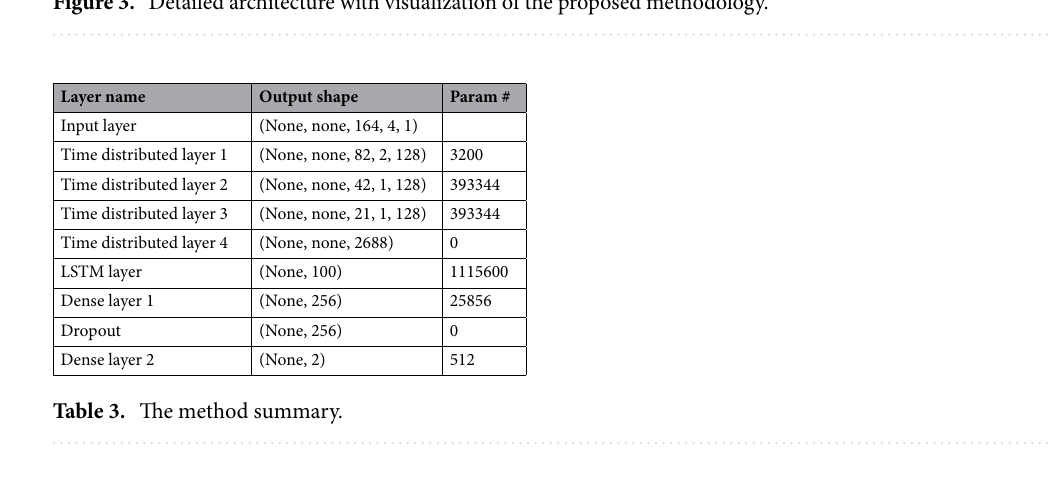
Figure 3. Detailed architecture with visualization of the proposed methodology.